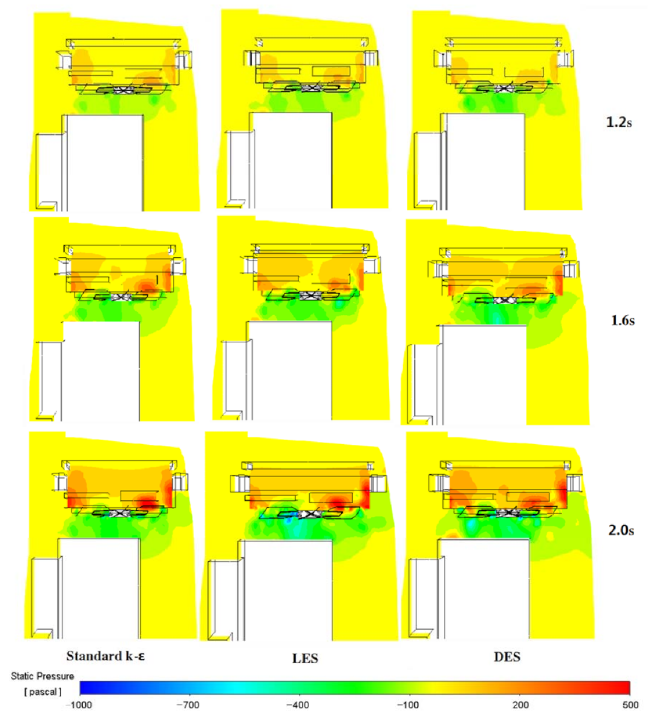
Figure 6. 2D contours of pressure magnitude at YZ plane.